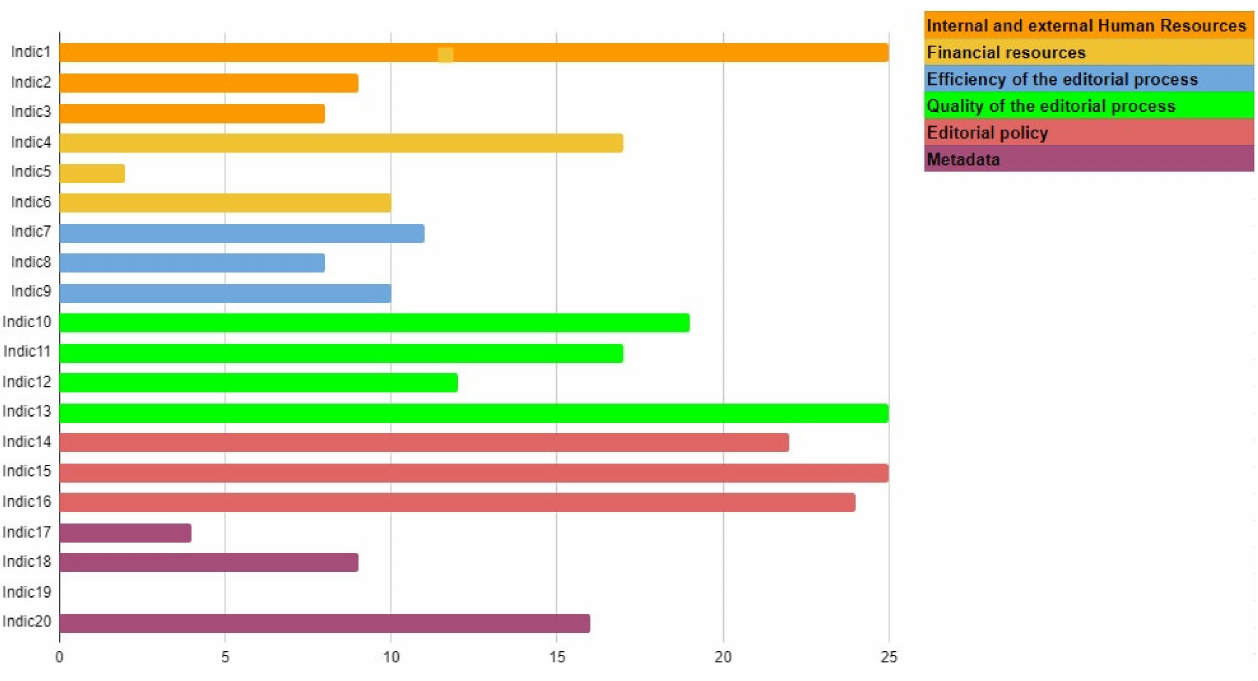
Figure 1. Aggregate values of the